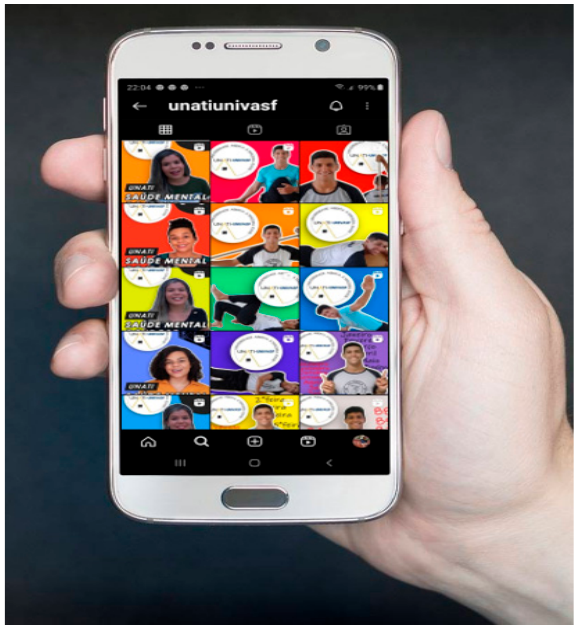
Figure 3. U3A/UNIVASF Instagram, videos of the program “U3A in Motion” (2020–2021).